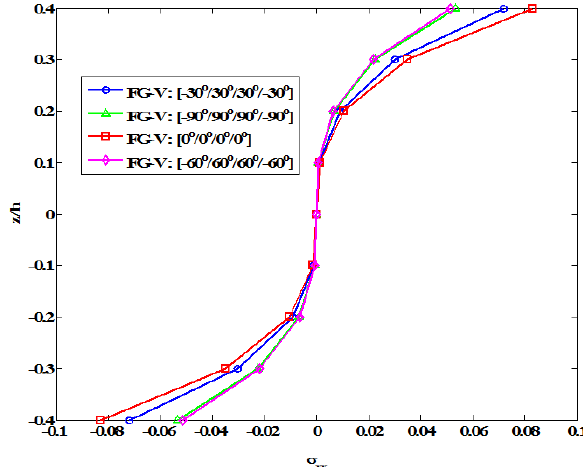
Figure 8: The non-dimensional stress σ xx for angle–ply [- θ / θ / θ /- θ ] UD plate with different lamination scheme